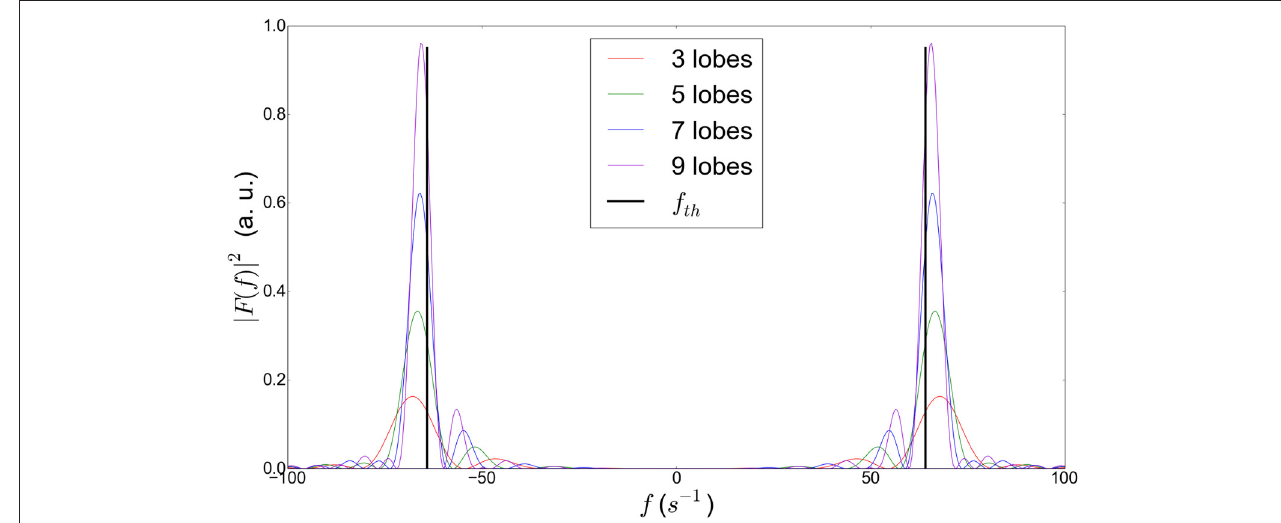
FIGURE 2 | Power modulation spectra for trapezoidal cosine OGSE gradient waveforms at 64 Hz for different number of half periods (or lobes), showing the influence of the number of lobes on the frequency selectivity. The theoretical peak frequency is denoted as f th . We observe that the difference between this theoretical peak and the actual frequency peak of the sequence decreases with increasing number of lobes. The actual frequency peak (not the theoretical one) of the OGSE sequences employed in this article is fed in our model for better